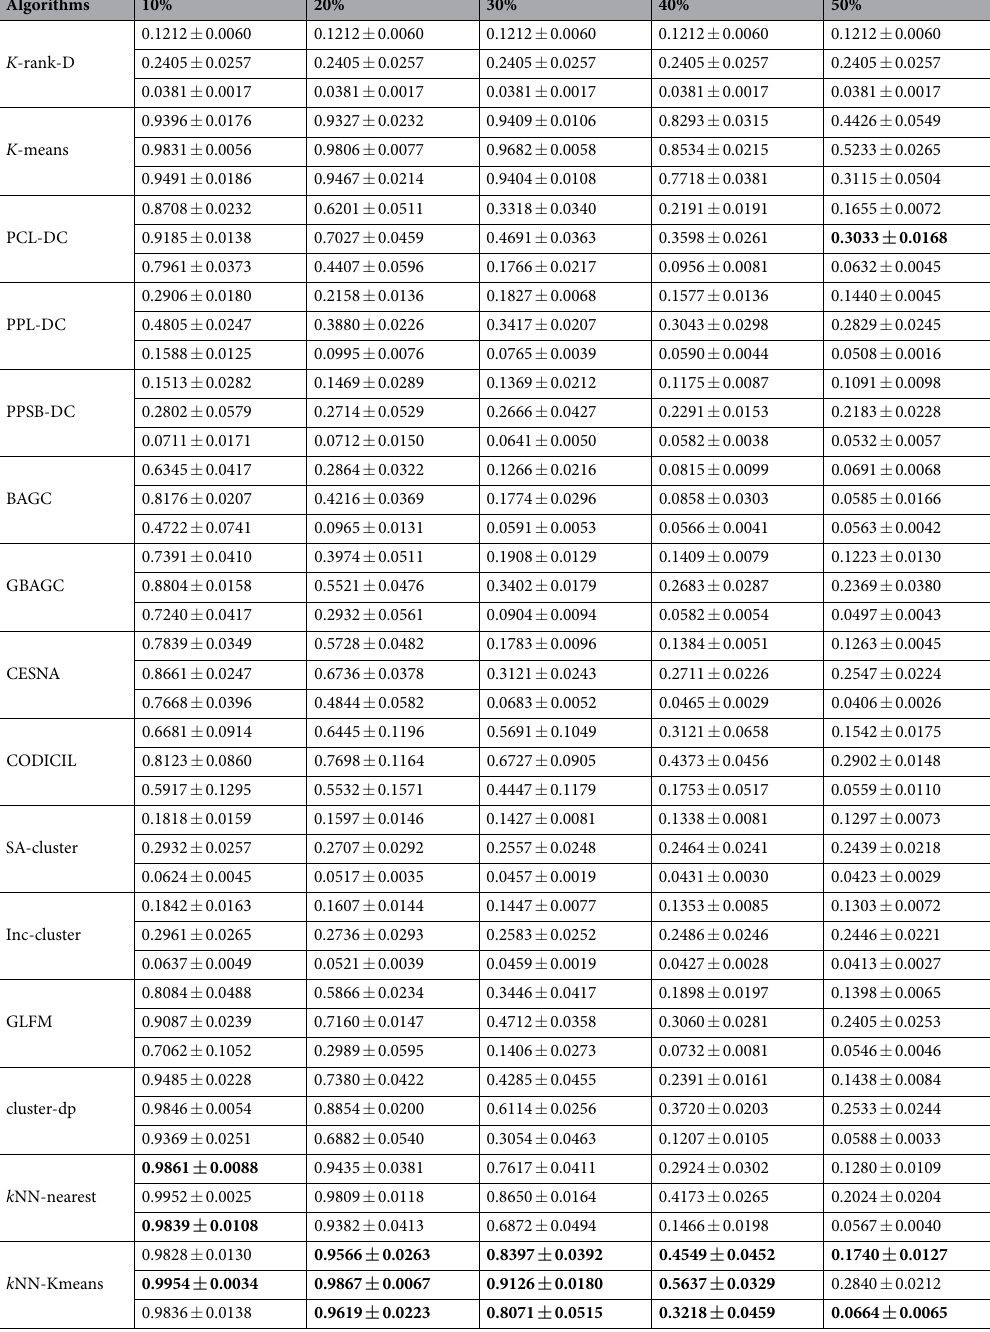
Table 3. Results on LFR networks with binary attributes, μ =